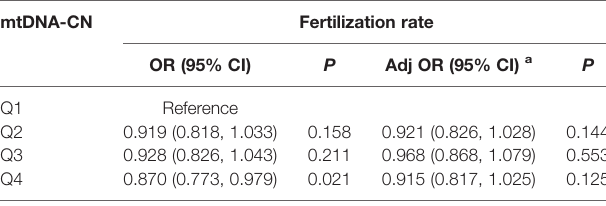
TABLE 3 | Association of mtDNA-CN with fertilization